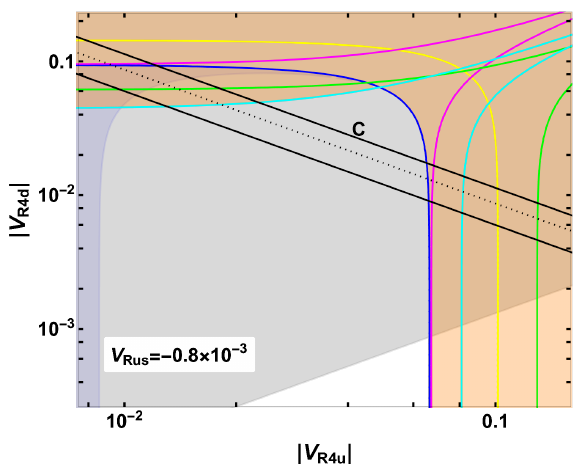
Figure 19 . Excluded area in the | V R 4 d | and | V R 4 u | parameter space. The orange area is excluded by the following low energy electroweak quantities: Z -boson decay rate (blue contour), Q W ( p ) (magenta), Q W ( Cs ) (cyan), the couplings g eu +2 g ed (green) and 2 g eu − g ed (yellow). The black AV AV AV AV curve is the needed solution | V Rud | = | V ∗ V R 4 d | = 0 . 87(27) × 10 − 3 in eq. (6.17). A conservative R 4 u value | V Rus | = | V ∗ V R 4 s | = 0 . 8 × 10 − 3 is used in order to satisfy the second relation of the R 4 u